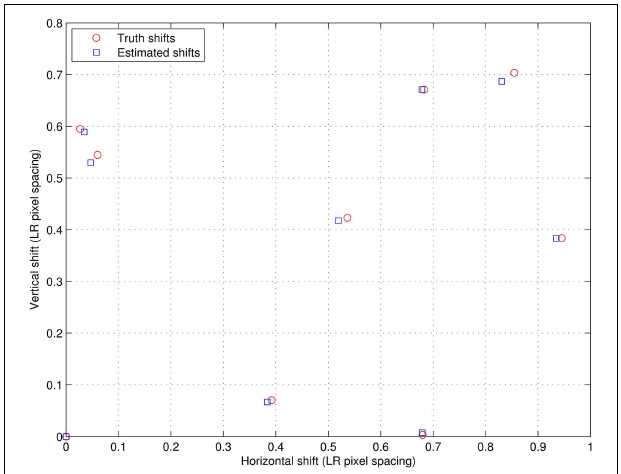
FIGURE 4 | The translational truth and estimated shifts for the nine simulated LR frames.